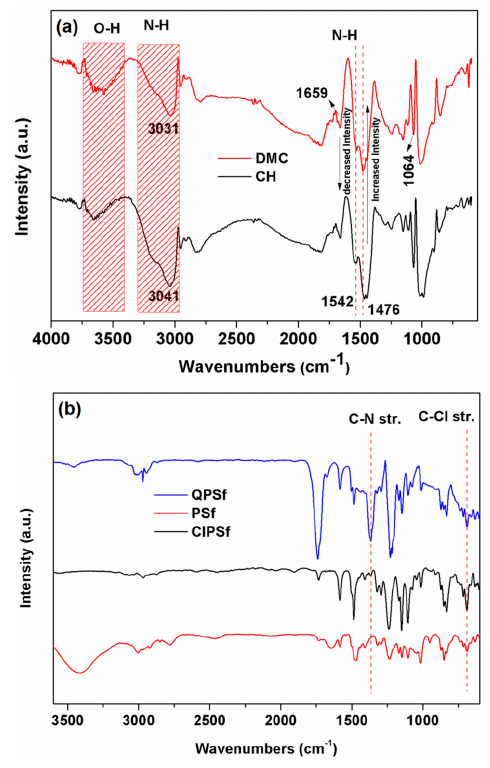
Figure 1. Fourier transform infrared (FTIR) spectra ( a ) chitosan (CH) and N , N -dimethyl chitosan (DMC); and ( b ) polysulfone (PSf), chloromethylated polysulfone (ClPSf) and quaternized PSf/dibromo butane (QPSf/DBB).